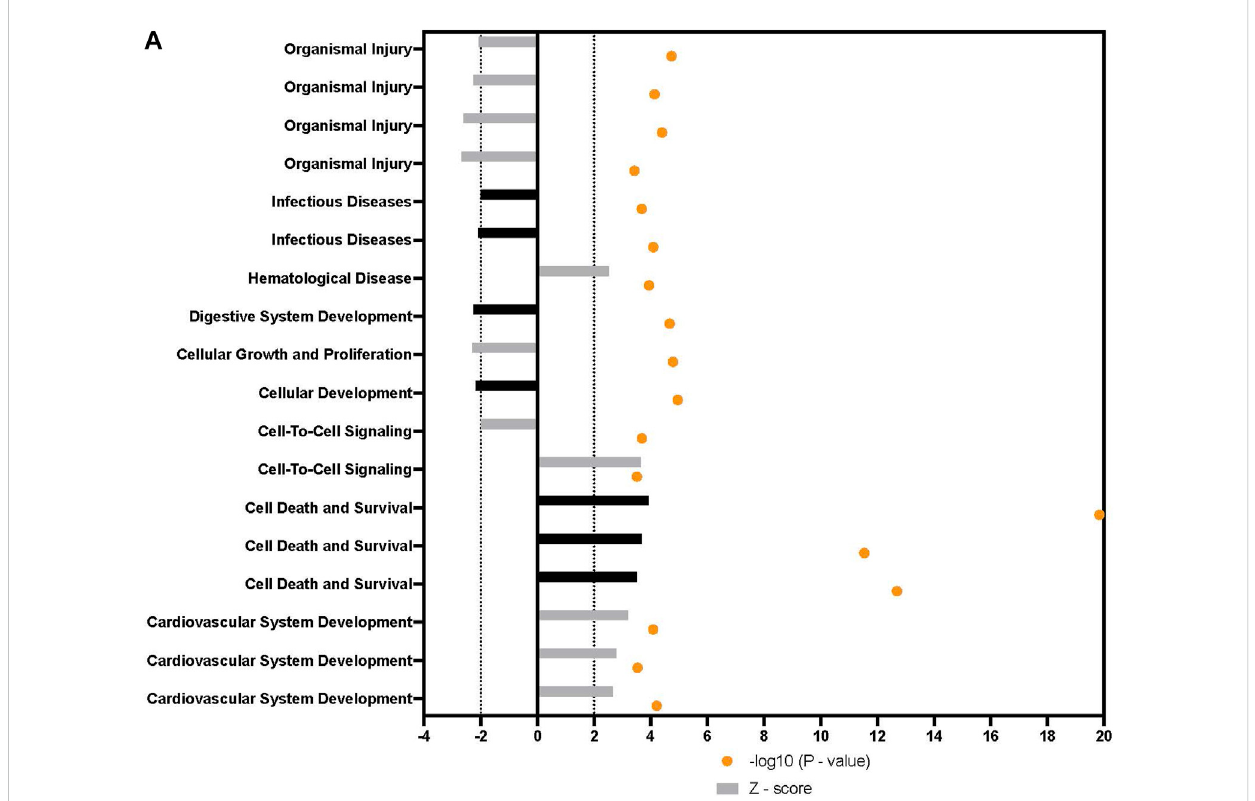
FIGURE 8 Downstream trends analysis of differentially expressed genes in hASCs induced towards osteogenesis post microbial challenge. The IPA regulation z-score algorithm was used to identify biological functions expected to increase or decrease based on the gene expression changes observed in our dataset.Predictionsbaseon p -valueandz-score;positivez-scoreimpliesanincrease inthepredictedfunction, anegativez-scoreadecrease(z-score ≥ 2 or ≤ − 2 represented by black dotted lines). p -values ≤ 0.05 (orange dots determined by Fischer ’ s exact test), illustrate a signi fi cant